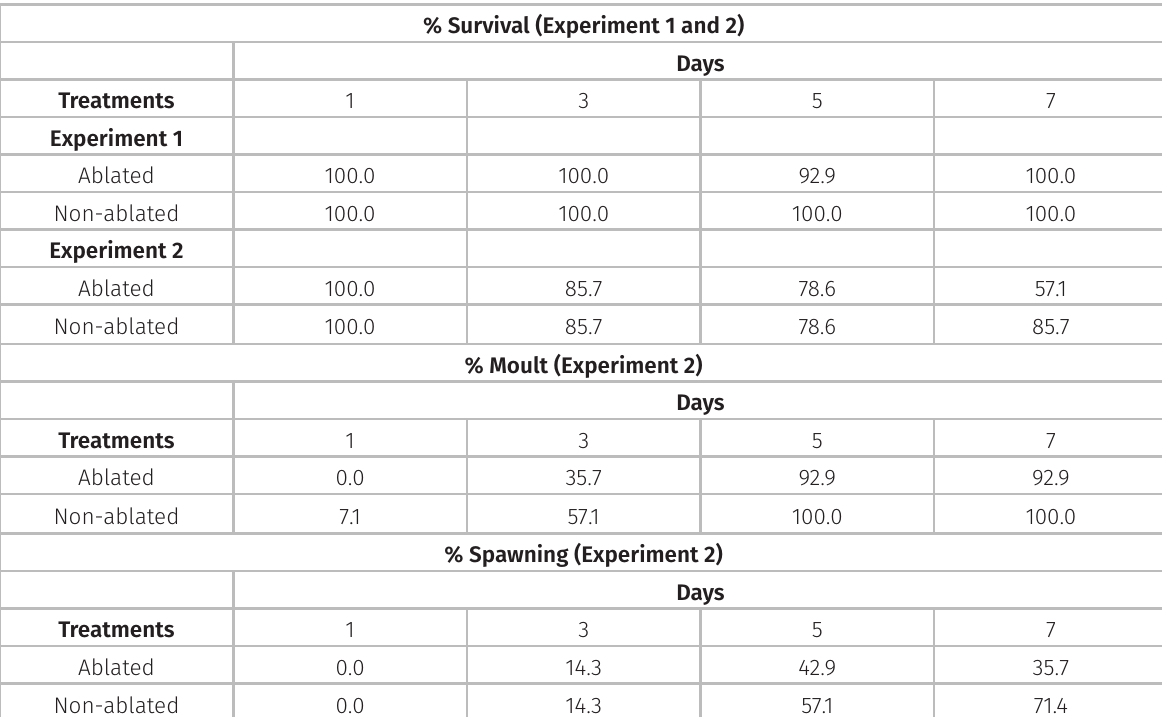
Table IV. Means of the variables analyzed in females of Macrobrachium acanthurus both in ablated/non-ablated females assigned on different monitoring days (1, 3, 5 and 7) of experiments 1 and